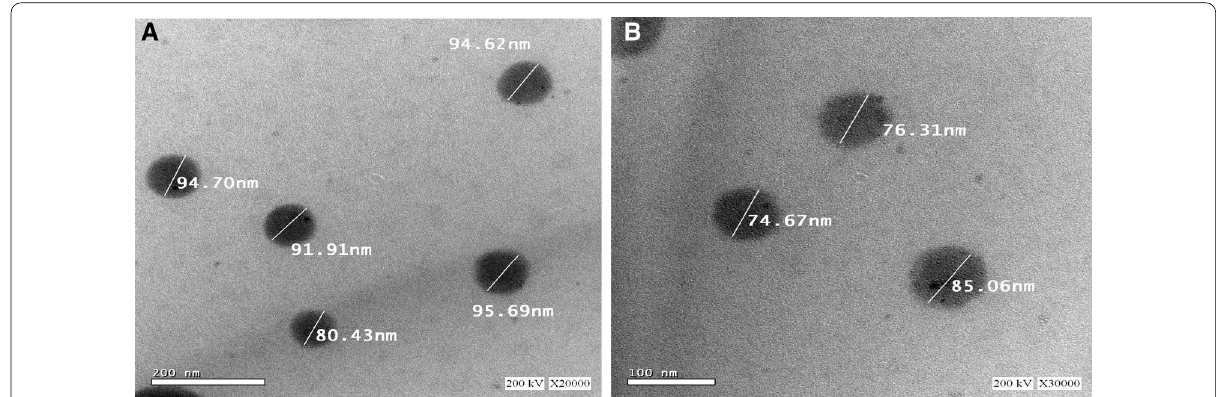
Fig. 3 Representative TEM images of TPC5 ( A ) at magnification 20,000 and ( B ) at magnification